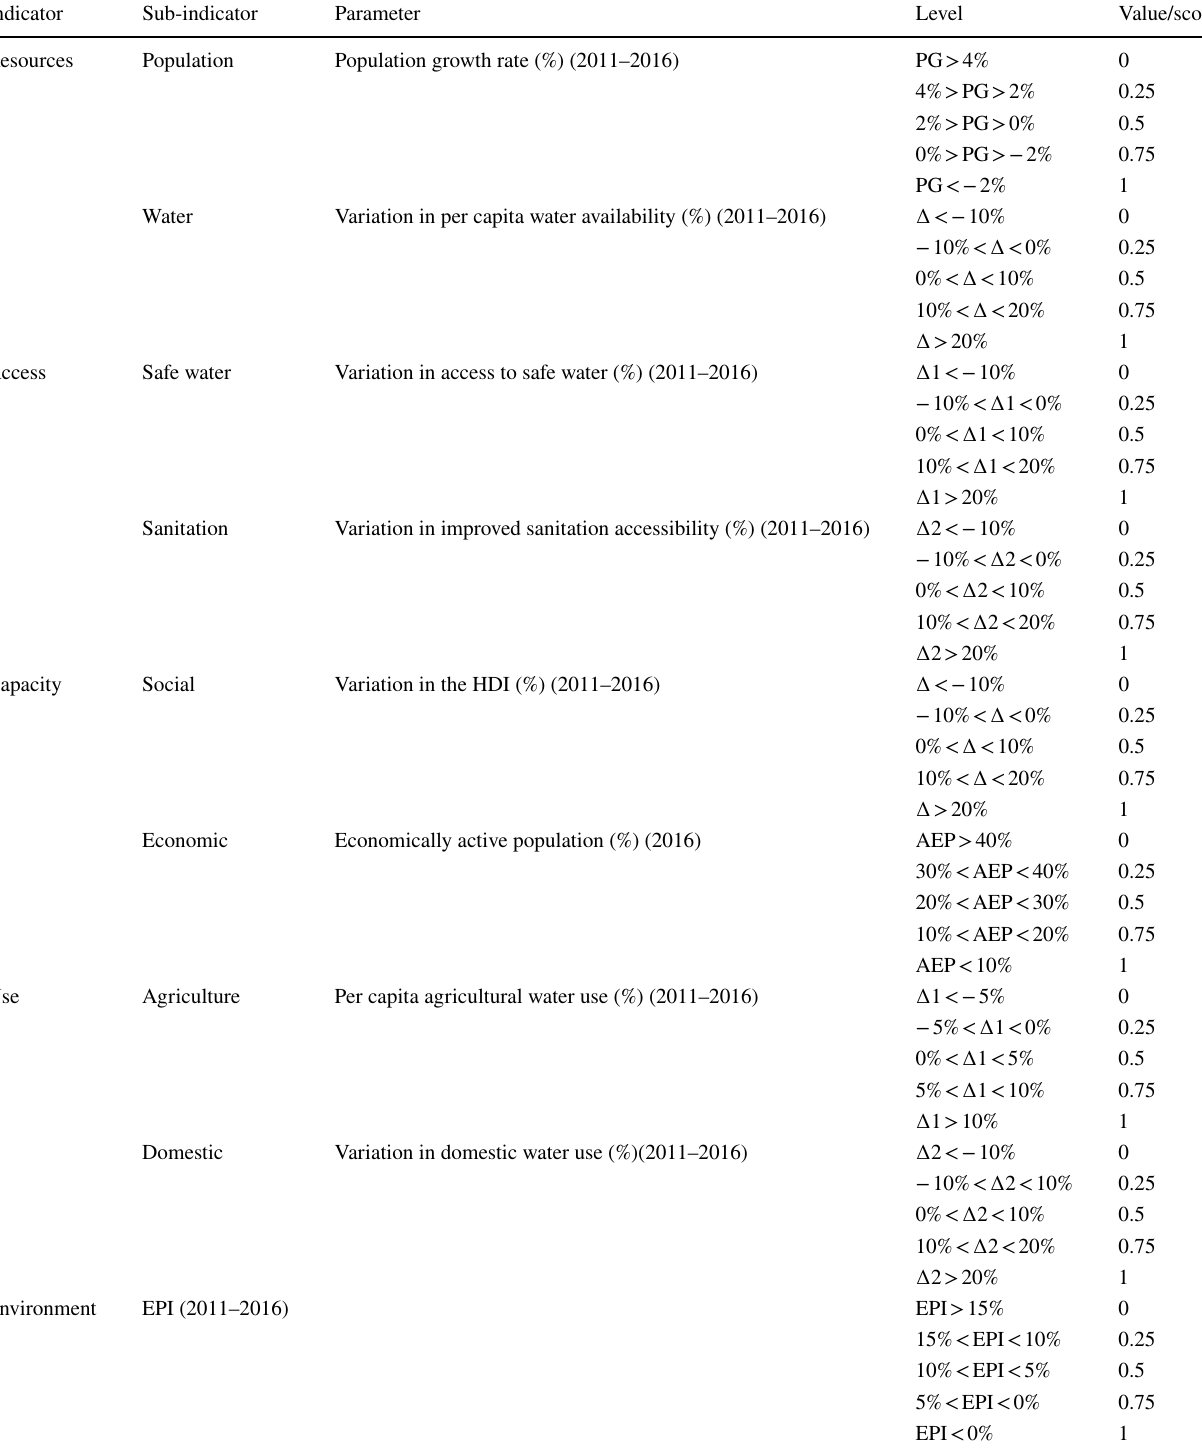
Table 1 eWPI pressure parameters and their values Indicator Sub-indicator Parameter